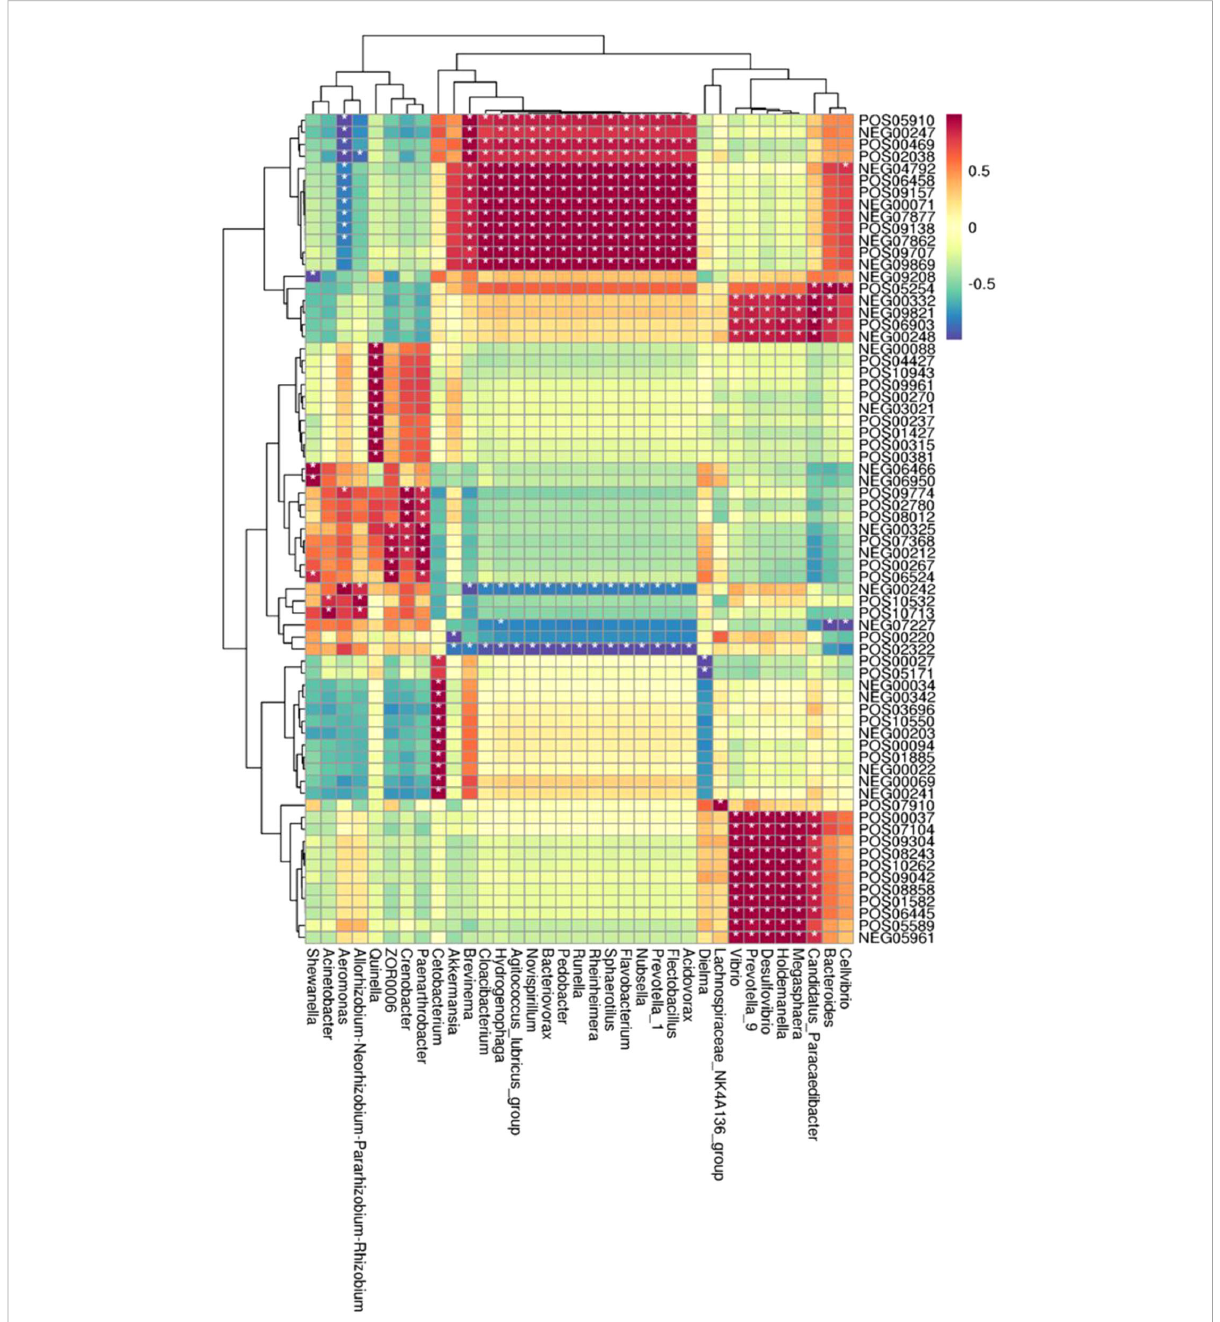
FIGURE 9 Heatmap of the correlation between gut metabolites and the microbiota. The horizontal axis represents bacterial species, and the vertical axis represents the metabolites. Grid means the correlation index. The color from white to red means a positive correlation from weak to strong, and white to blue means a negative correlation. *, signi fi cant correlation with a p -value less than 0.05; **, highly signi fi cant correlation with a p - value less than